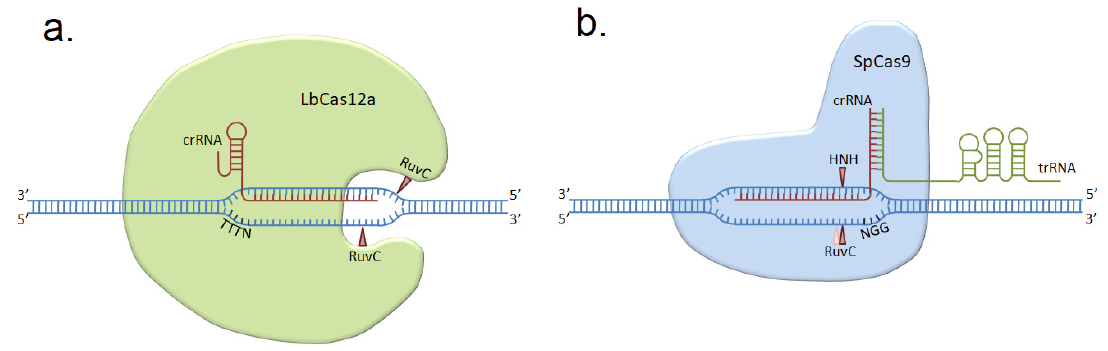
Figure 1. The mechanisms of action of LbCas12a ( a ) and SpCas9 ( b ) nucleases. LbCas12a cleaves far from PAM and SpCas9 cleaves near PAM, in the seed region. TTTN -represents the PAM sequence for LbCas12a, NGG is the PAM sequence for SpCas9, cleavage sites by nuclease domains (RuvC and HNH) are labeled with red triangles (pink triangle labels an alternative cut site, producing staggered ends).